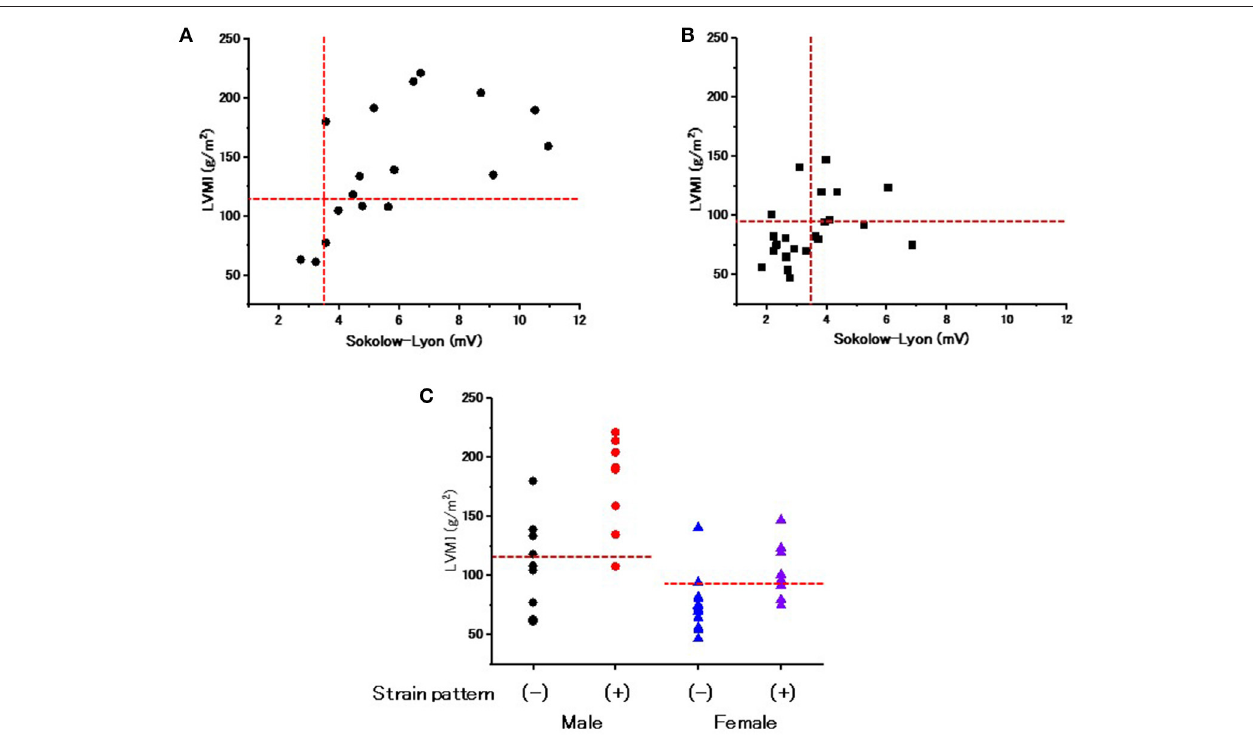
FIGURE 5 | The evaluation of left ventricular hypertrophy and repolarization abnormality on ECGs after long-term enzyme replacement therapy. (A) The relationship between the Sokolow-Lyon index and left ventricular mass index (LVMI) evaluated by echocardiography in male patients after long-term enzyme replacement therapy. Horizontal dotted lines indicate the cut-off value of left ventricular hypertrophy by echocardiography. Vertical dotted lines indicate the cut-off value of left ventricular hypertrophy by the Sokolow-Lyon index. (B) The relationship between the Sokolow-Lyon index and LVMI evaluated by echocardiography in female patients after long-term enzyme replacement therapy. Horizontal dotted lines indicate the cut-off value of left ventricular hypertrophy by echocardiography. Vertical dotted lines indicate the cut-off value of left ventricular hypertrophy by the Sokolow-Lyon index. (C) The LVMI with and without a strain pattern after long-term enzyme replacement therapy. Dotted lines indicate the cut-off value to determine left ventricular hypertrophy. Closed black circles indicate the male patients without a strain pattern. Closed red circles indicate the male patients with a strain pattern. Blue triangles indicate the female patients without a strain pattern. Purple triangles indicate the female patients with a strain